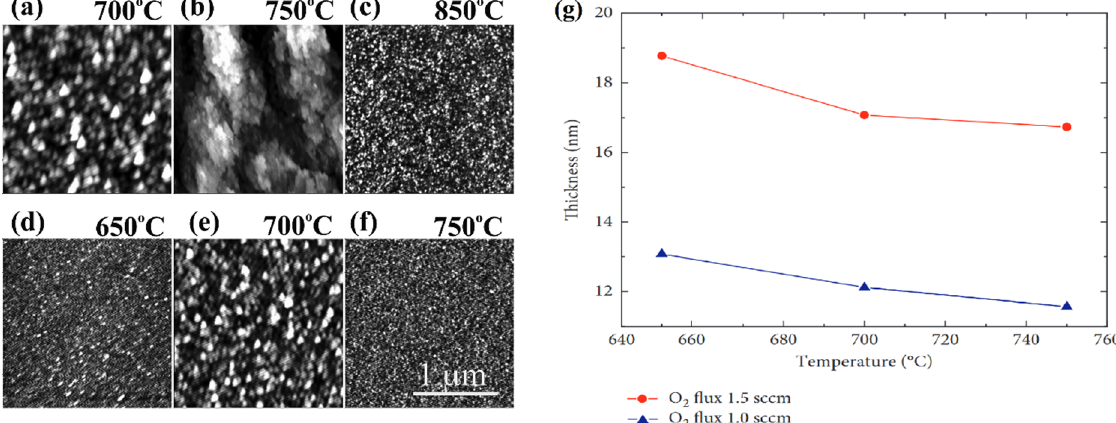
Figure 10. The AFM of the gallium oxide thin films synthesized by MBE by varying the growth temperature ( a – f ) 650-850 °C [147]. “Reprinted with permission from Ref. [147]. Copyright (2016), AIP Publishing.”. ( g ) variation in the thickness of two different samples prepared by varying oxygen flux over the temperature range [151]. “Reprinted with permission from Ref. [151]. Copyright (2018), Hindawi”.